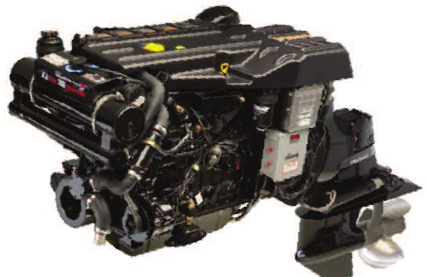
Figure 2. Vector propulsion